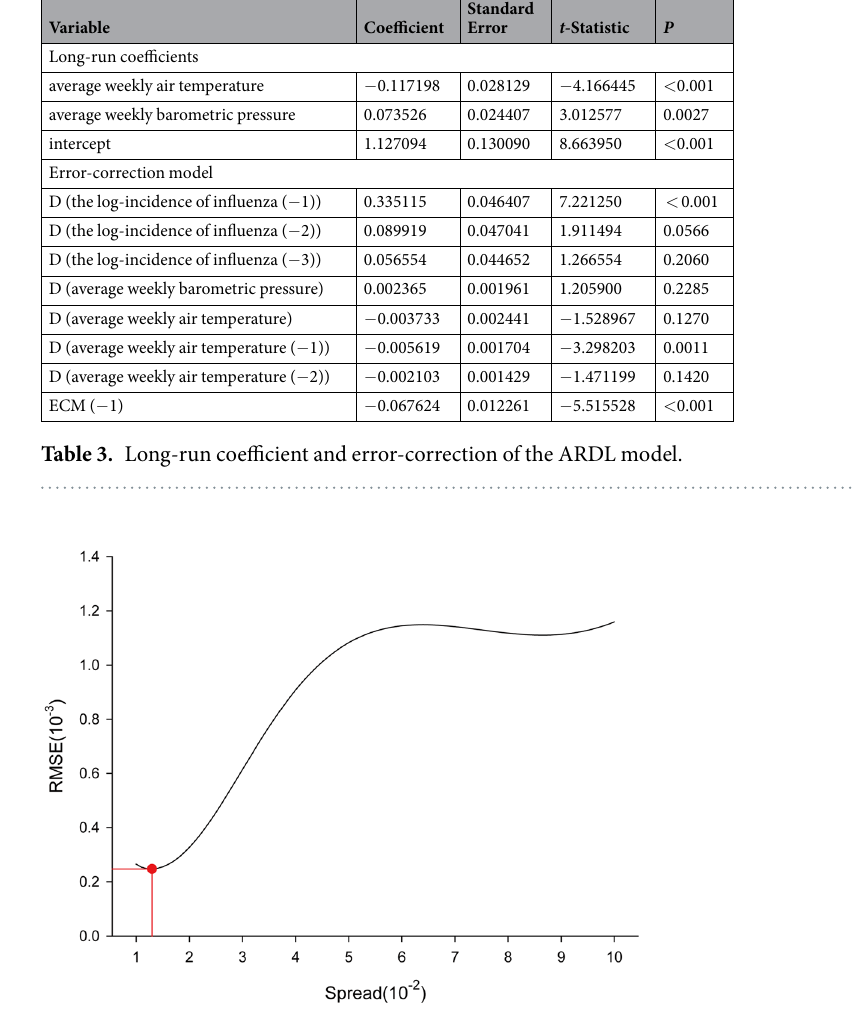
Figure 3. Selection of the optimal spread of the ARDL-GRNN hybrid model in training samples. When the spread is 0.013, the RMSE (the red point) 2.48 × 10 − 4 of the training samples is the least. In principle, if the RMSE for the training samples is the least, the spread is the